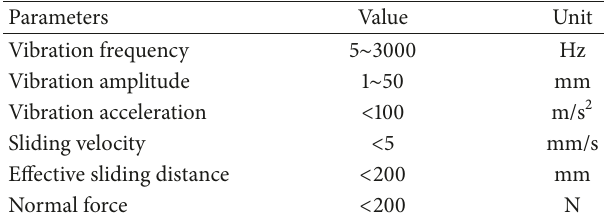
Table 2: Main technical parameters of test